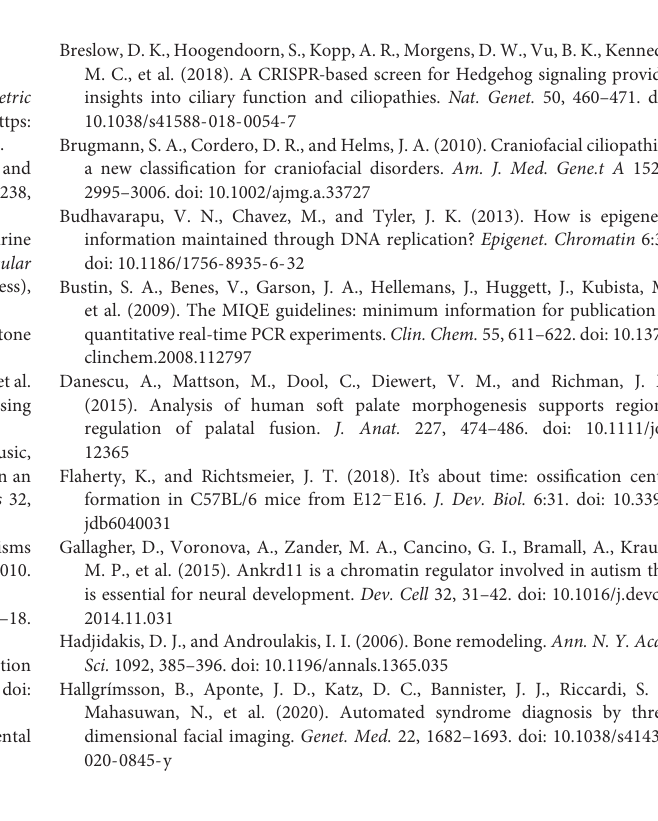
Supplementary Figure 1 | Landmarks used for mesh morphometric analysis. Sixty-eight anatomical landmarks placed on micro-CT volumes of the cranium using the MINC toolkit. Supplementary Figure 2 | Ankrd11 ncko mice are born with a macroscopically recognizable craniofacial phenotype. Left column: Ankrd11 ctrl P0 mice. Right column: Ankrd11 ncko P0 mice. (A,B) Lateral view of head, with a white arrow indicating layer of skin covering eye, incomplete in Ankrd11 ncko mice. Ankrd11 ncko mice also have a growth deficiency in the midface and retrognathia. (C,D) Superior view of head. Ankrd11 ncko appears paler, with a more domed head shape. (E,F) View of the snout from the front. White arrow indicates black pigment that is absent in Ankrd11 ncko mice. (G,H) View of dissected palate, viewed from below. Left side is anterior. Asterisk highlights cleft palate in Ankrd11 ncko mouse. (I,J) View of dissected mandible and tongue, viewed from above. Left side is anterior. Note tongue (central, spanning left to right in image) is thinner and shorter in Ankrd11 ncko mouse. Consistent amongst three mice from different litters. Supplementary Figure 3 | Cleaved Caspase 3 (CC3) dependent apoptosis does not differ between Ankrd11 ctrl and Ankrd11 ncko palatal shelves. Representative immunofluorescent staining for cleaved caspase 3 (CC3) on coronal paraffin sections (green). Nuclei are counterstained with DAPI (red). n = 3 from 3 l. Scale bar represents 50 µ m on all images. Supplementary Table 1 | Antibodies used for immunofluorescent staining. Supplementary Table 2 | Oligonucleotide primer pairs used for quantitative